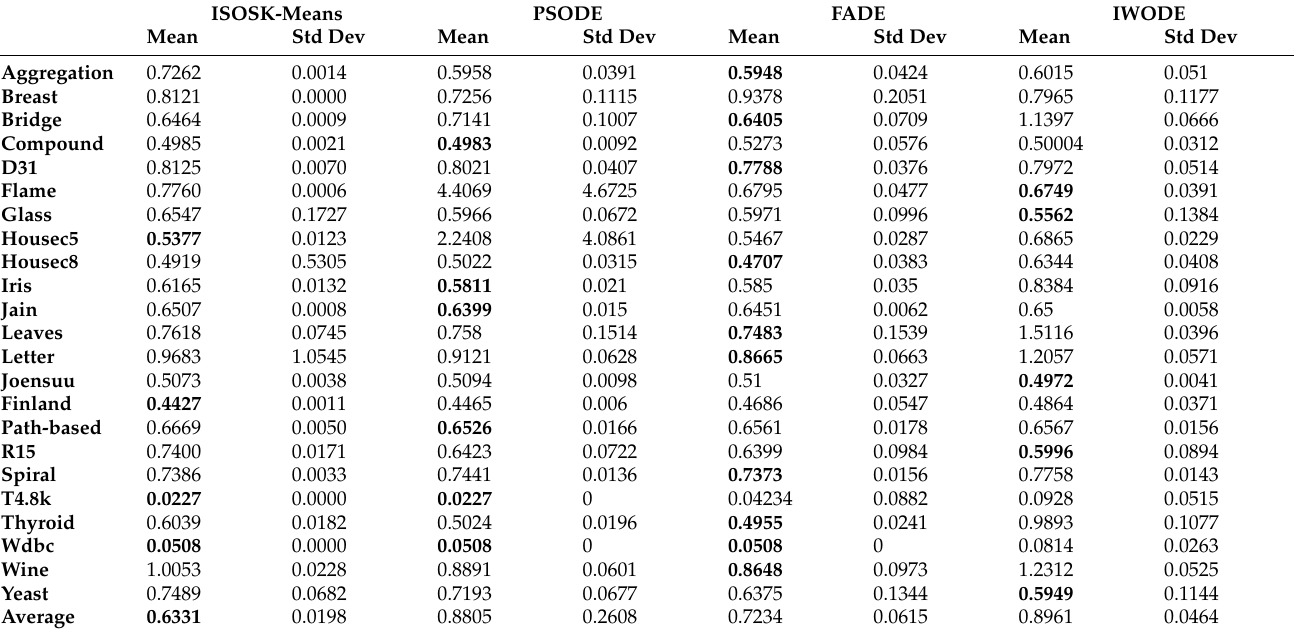
Table 9. Performance comparison of ISOSK-means with other hybrid metaheuristic algorithms on 23 real-life